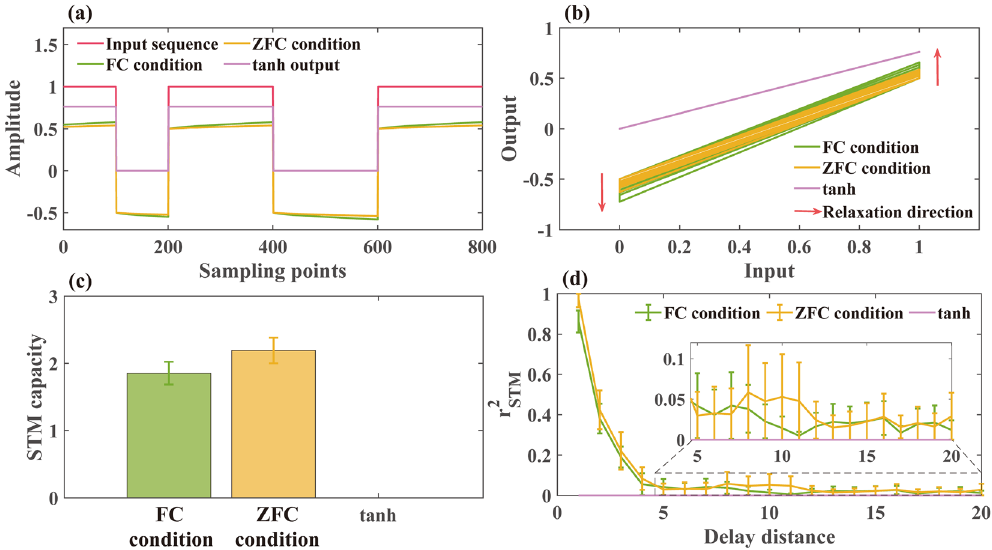
Figure 4. ( a ) Input binary sequence and the output from the spin glass relaxation term of FC condition, ZFC condition, and tanh function, respectively. Each binary code is sampled into 100 discrete points. ( b ) Relationship curve between input binary sequence and the output from each system. ( c ) short-term memory 2 capacity and ( d ) r STM ( d ) of each